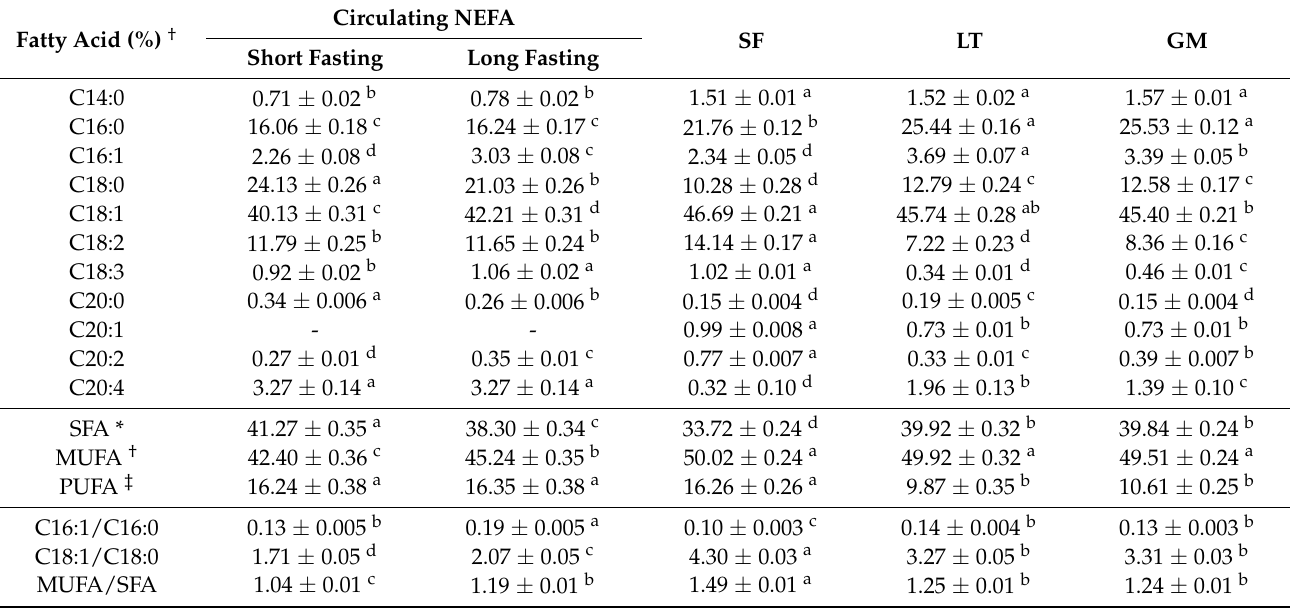
Table 2. Circulating NEFA after 12-h (short) and 24-h (long) fasting and fatty acid composition of tissues.